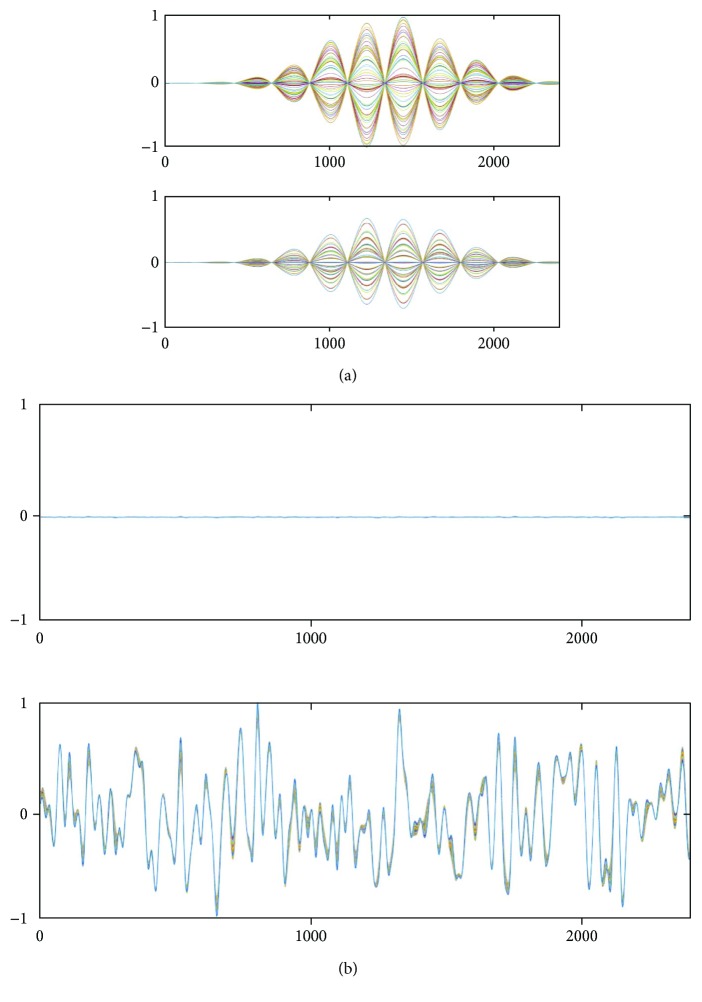
Results of experiments that apply the SSS extractors to bS(t) and bI(t) computed assuming the flat sensor array in Figure 2(a). (a) The upper and lower panels, respectively, show PintbS(t) and PextbS(t), which indicate the internal and external components in bS(t). (b) The upper and lower panels, respectively, show PintbI(t) and PextbI(t), which indicate the internal and external components in bI(t). In the sensor time courses in (a), they are normalized to the maximum value from the upper panel, and the sensor time courses in (b), they are normalized to the maximum value from the lower panel.